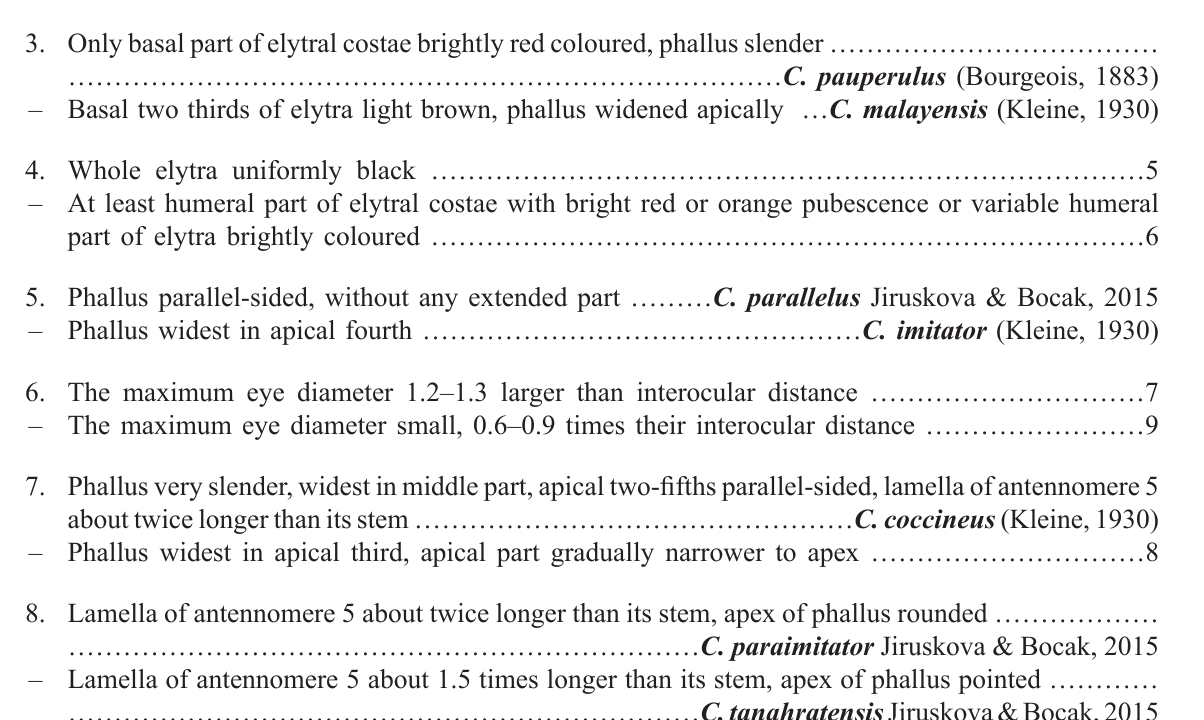
Phallus widest in apical third, apical part gradually narrower to apex